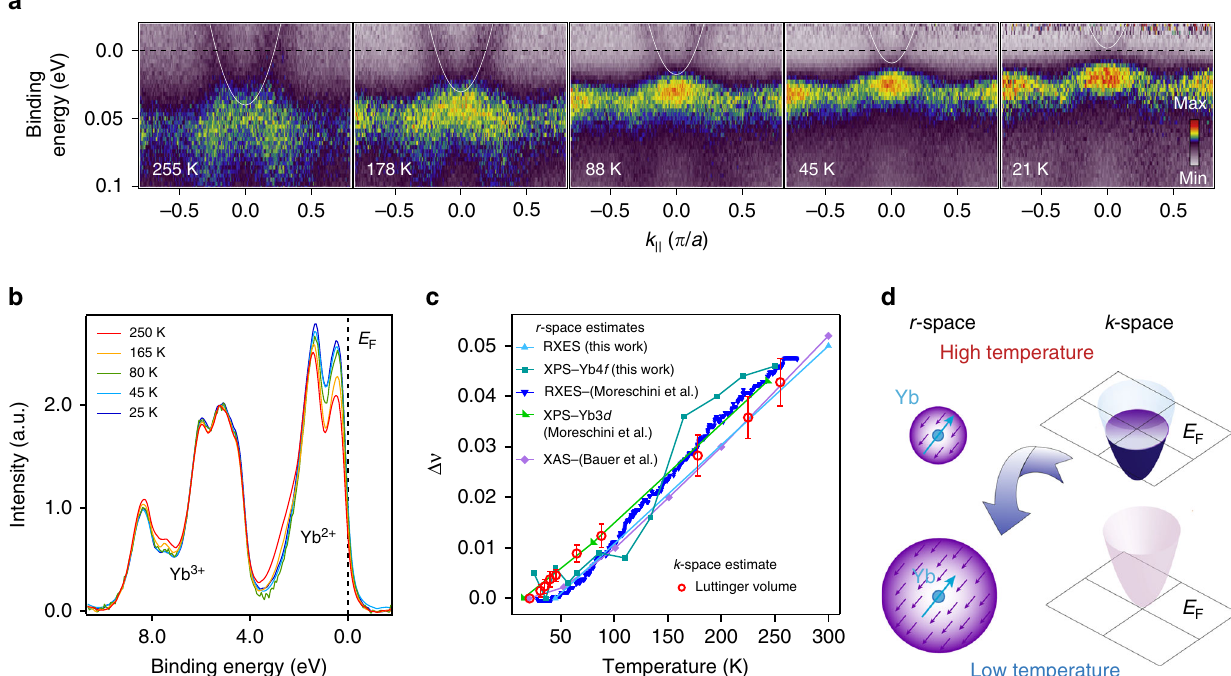
Fig. 2 Correspondence between r -space and k -space electronic structure in YbAl 3 . a Evolution of the low-energy electronic structure with temperature. E vs. k dispersions are divided by the corresponding resolution-broadened Fermi-Dirac distribution to emphasize thermally occupied states above E F . White lines are guides to the eye showing evolution of the electron-like pocket centered at (0, 0, 0). b XPS spectra showing the temperature-dependent intensity variation of the 4 f 13 and 4 f 12 fi nal states in YbAl 3 , after Shirley background subtraction 37 and normalized by the 4 f 12 fi nal state intensity. c Temperature dependence of the change in Luttinger volume, estimated from the size of the electron pocket at (0, 0, 0) and of the change in Yb valence, measured by core-level spectroscopy, revealing a precise one-to-one correspondence. Error bars re fl ect uncertainty in the Luttinger volume estimation due to a statistical error of one standard deviation in the extracted k F values from the fi ts to the Momentum distribution curves (MDCs) taken at E F . d Schematic illustrating the temperature-dependent relationship between r -space and k -space electronic structure in YbAl